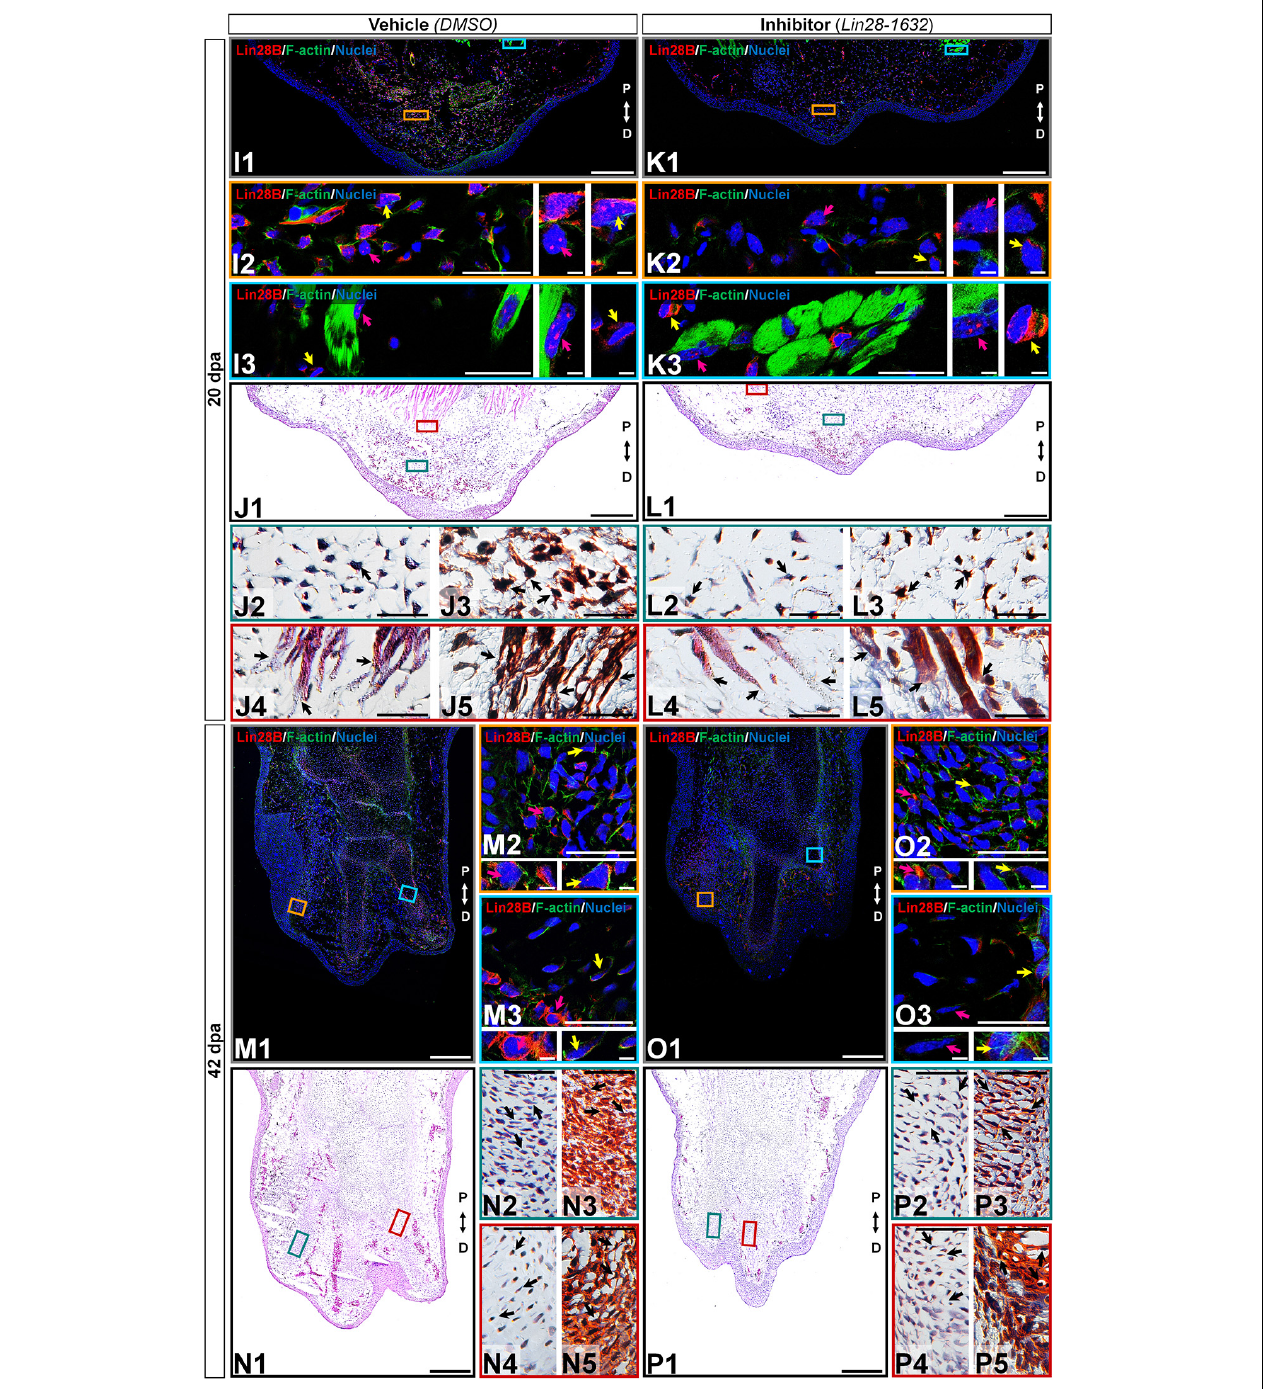
FIGURE 8 | Histological changes after functional inhibition of Lin28 in key regeneration stages (continuation). (K,L,O,P) Histological sections of limbs treated with Lin28-1632 inhibitor, oriented in the Proximal-Distal axis. (I,J,M,N) Histological sections of limbs treated with vehicle, oriented in the Proximal-Distal axis. (I–L) Medium blastema stage (20 dpa). (M–P) Late palette–early digits stage (42 dpa). (I1,K1,M1,O1) Subcellular localization of amxLin28B marked in red, by contrast with DAPI (blue) and Phalloidin (green). Scale bars: 500 µ m. (I2-3,K2-3,M2-3,O2-3) Magnifications with different color contours to remark some areas of interest for amxLin28B in red, DAPI in blue, and Phalloidin in green; arrows in yellow and magenta have in turn their own zoom in. Scale bars: 50 and 5 µ m, respectively. (J1,L1,N1,P1) General tissue morphology shown with Hematoxylin and Eosin staining. Scale bars: 500 µ m. (J2/4,L2/4,N2/4,P2/4) Magnifications with distinct color contours to indicate some areas of interest in Hematoxylin and Eosin staining. Scale bars: 50 µ m. (J3/5,L3/5,N3/5,P3/5) Differential staining to view changes on stroma for similar zones indicated in H&E ampliations. Scale bars: 50 µ m. The distinct arrows point to diverse tissue components, as described in the results.